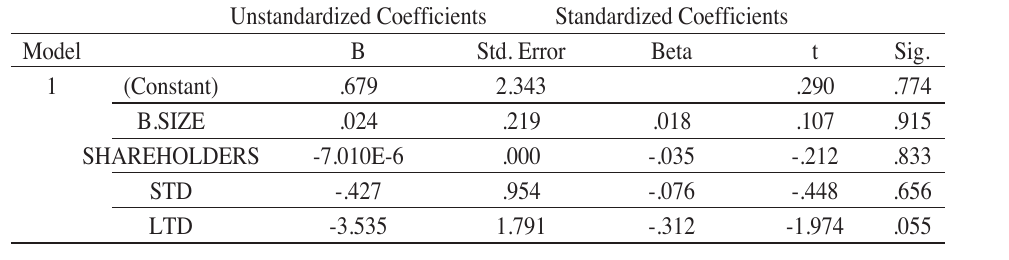
Table 9: Analysis of